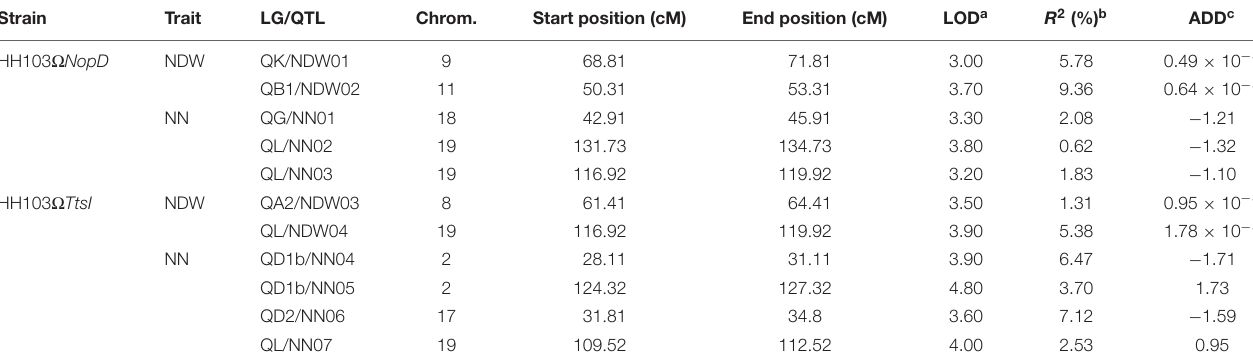
TABLE 2 | Distribution of conditional quantitative trait locus (QTL) for nodule number (NN) and nodule dry weight (NDW) among linkage groups and chromosomes. Strain Trait LG/QTL Chrom. Start position (cM) End position (cM) LOD a R 2 (%) b ADD